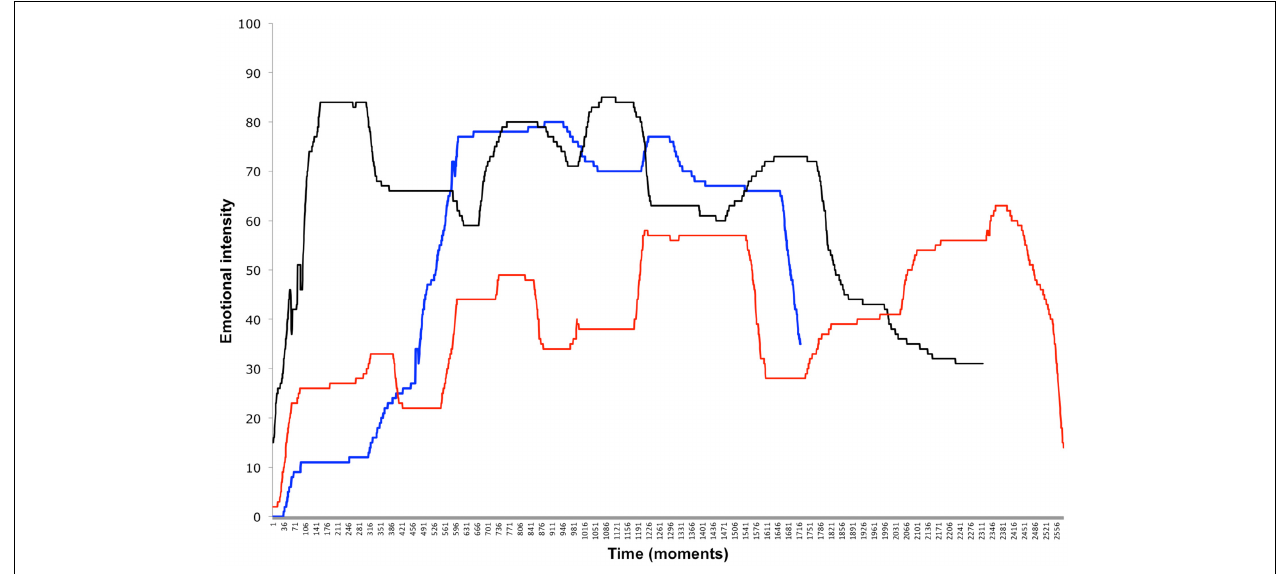
FIGURE 1 | The temporal profiles of emotional intensity ratings for three exemplary songs from one exemplary participant.